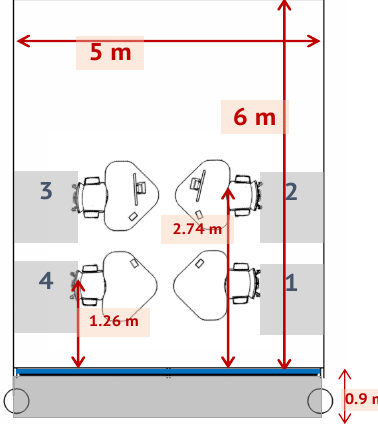
Figure 2. The layout of the model office